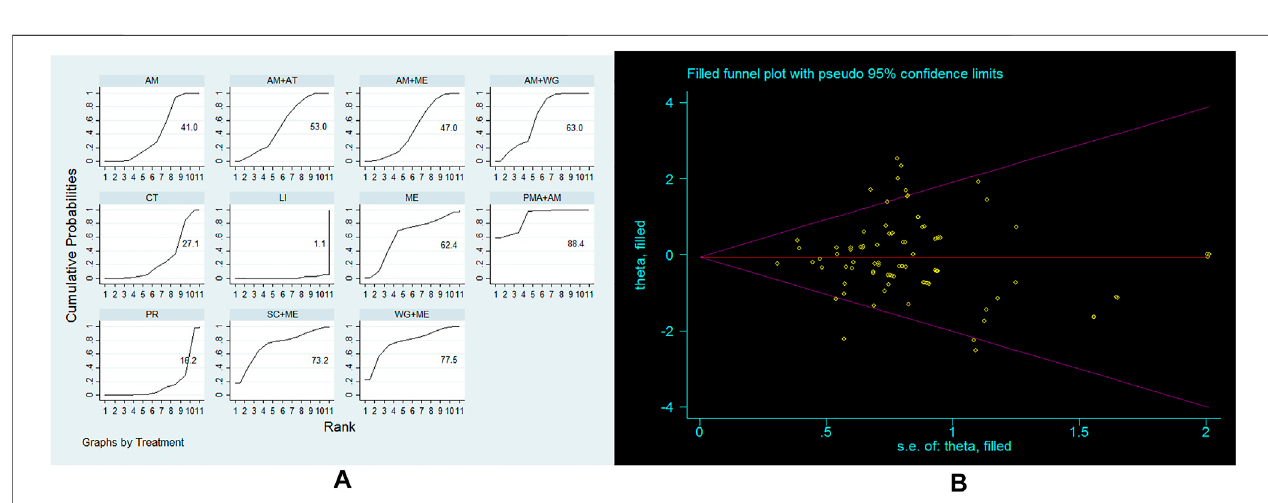
FIGURE 3 | (A) Ranking for adverse reaction rate of 11 treatment strategies; (B) Sensitivity analysis of this study.